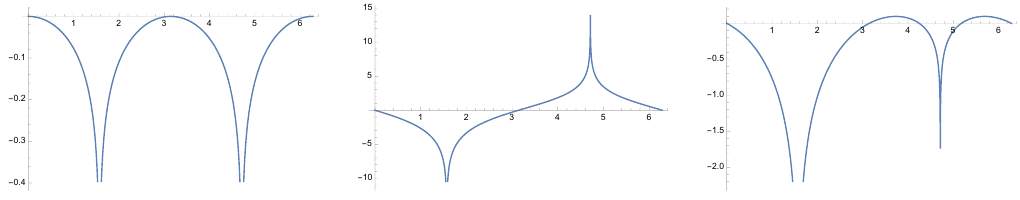
Figure 4 . The three functions ˆ U ( ϕ ) , ˆ ψ ( ϕ ) and ˆ V ( φ ) for the ETW 7 − brane. For the 7 + brane the plots are just shifted by π .